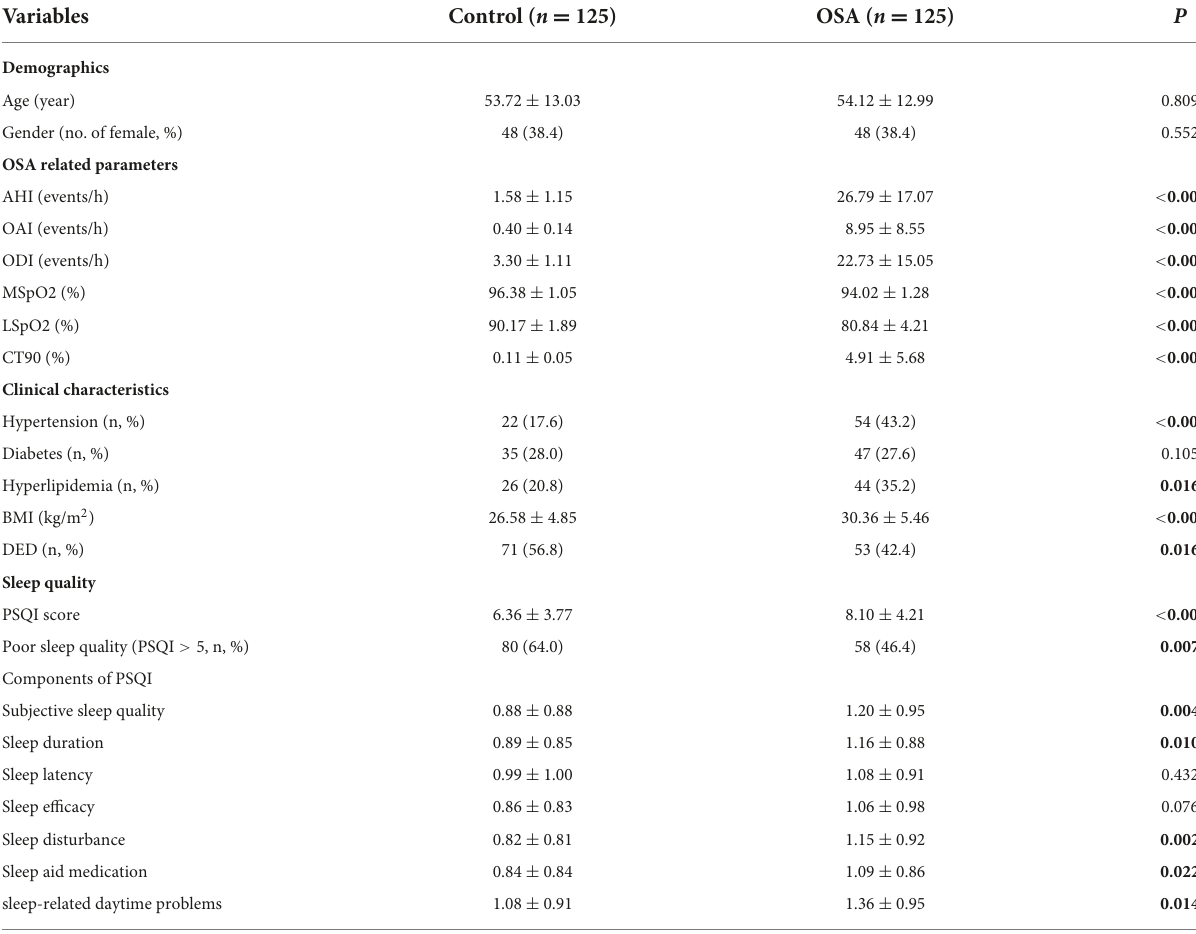
TABLE 1 Demographics, clinical characteristics, OSA-related parameters, DED incidence, and sleep quality in OSA cases and relevant controls. Variables Control ( n = 125)